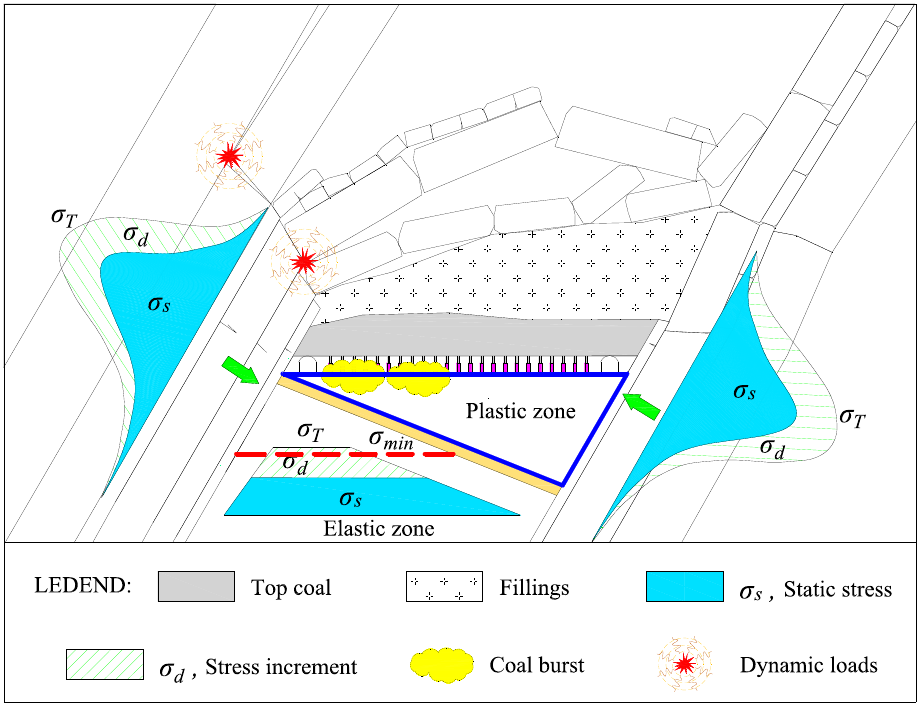
Figure 14. The mechanisms of rock burst in SIETCS.